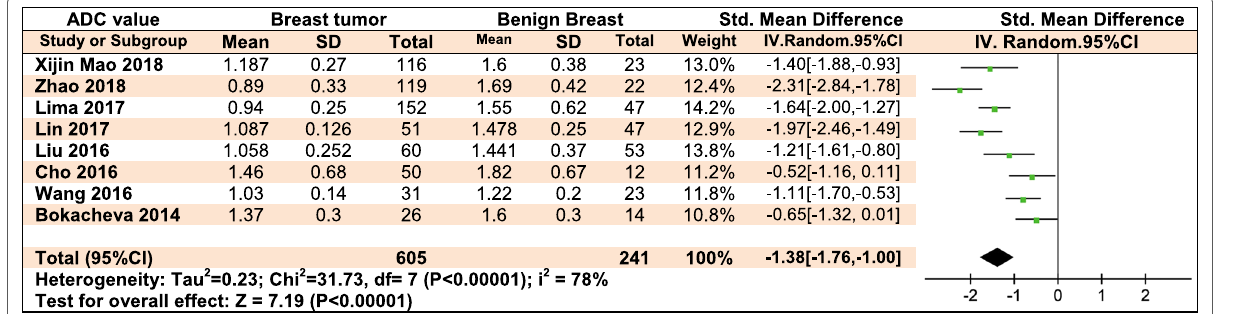
Fig. 2 The mean value of the apparent diffusion coefficient (ADC) distinguished among breast